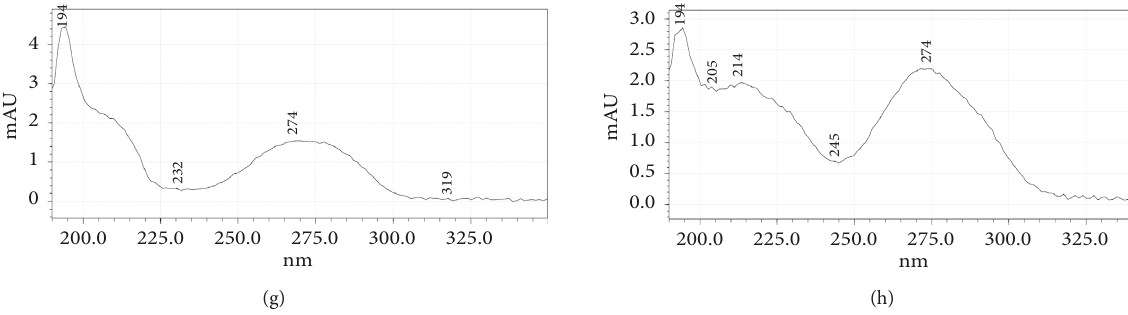
Figure 2: Chromatogram of mix standard solution (a), blank sample spiked with MI and MCI (b), blank sample (c), shampoo sample containing MI, MCI (d), peak purity (peak of MI (e) and peak of MCI (f)), and UV-Vis absorption spectra (spectrum of MI (g) and spectrum of MCI (h)) of